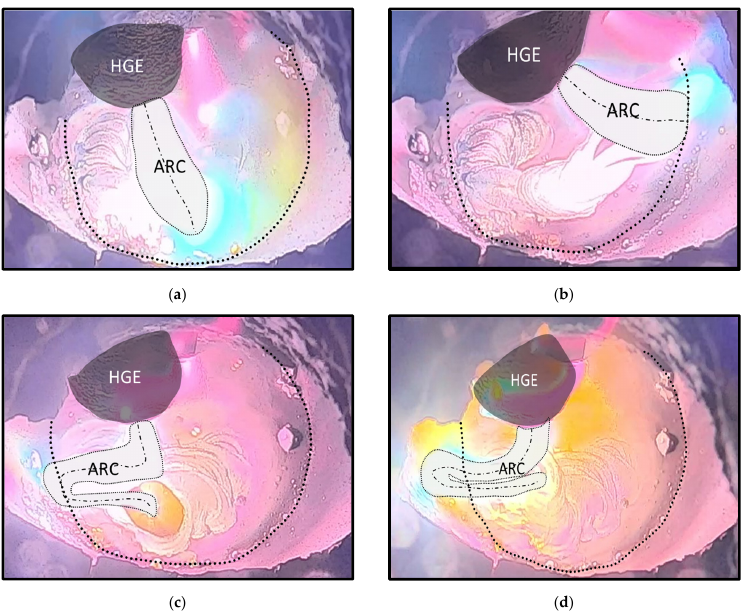
Figure 14. Di ff erent positions for the arc during operation: ( a ) stable centered position; ( b ) position at the operationlimit; ( c )invalidpositionandsignsofinstability; and( d )invalidposition,